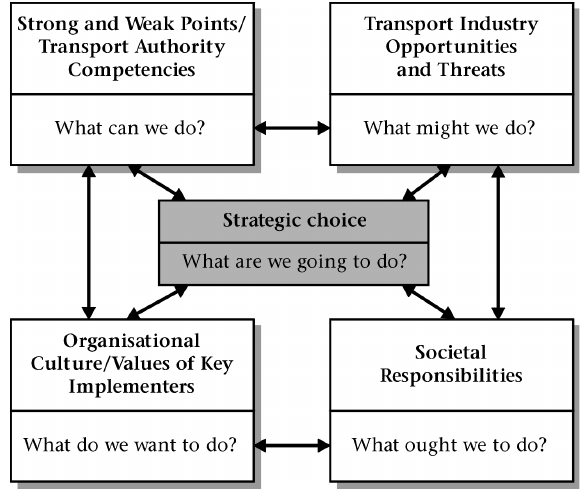
Figure 4: Process of making Strategic Choice (Leidtka & Rosenblum,